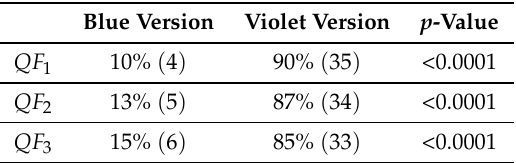
Table 3. The distribution of the preferences of the users participating in Experiment 2 for the blue and violet versions with the p -value for the chi-squared test.